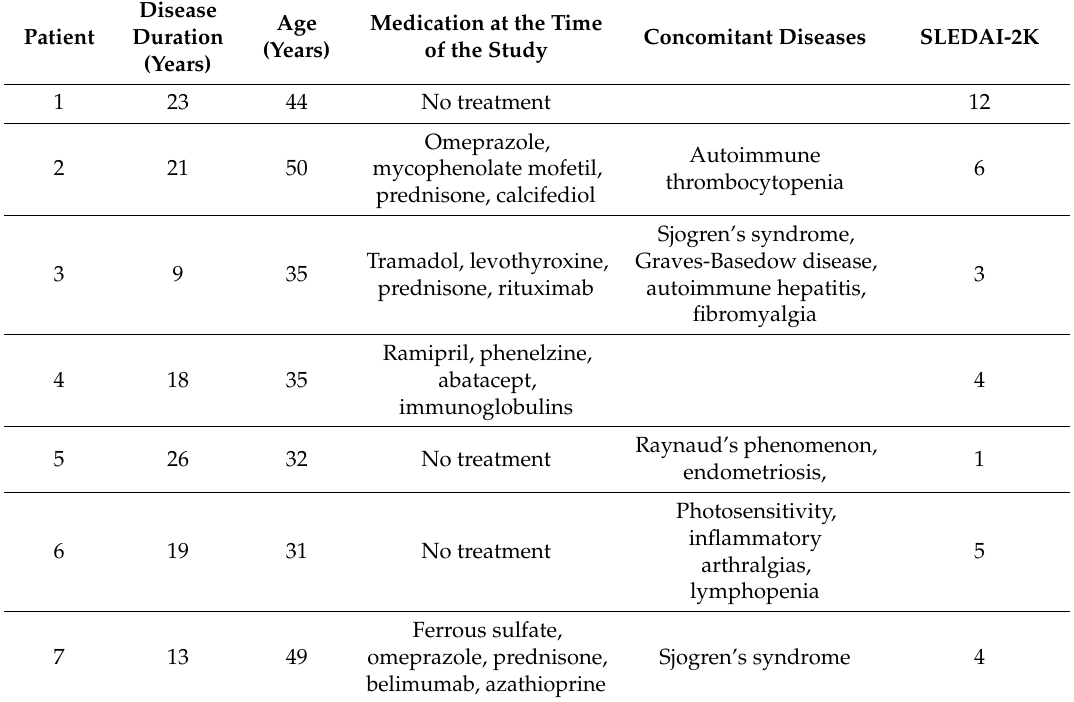
Table 1. Features of the patients with Systemic lupus erythematosus